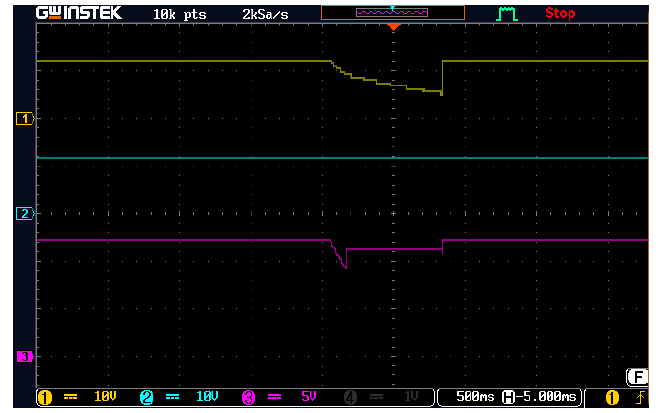
Figure 11. Waveforms of switching operation.